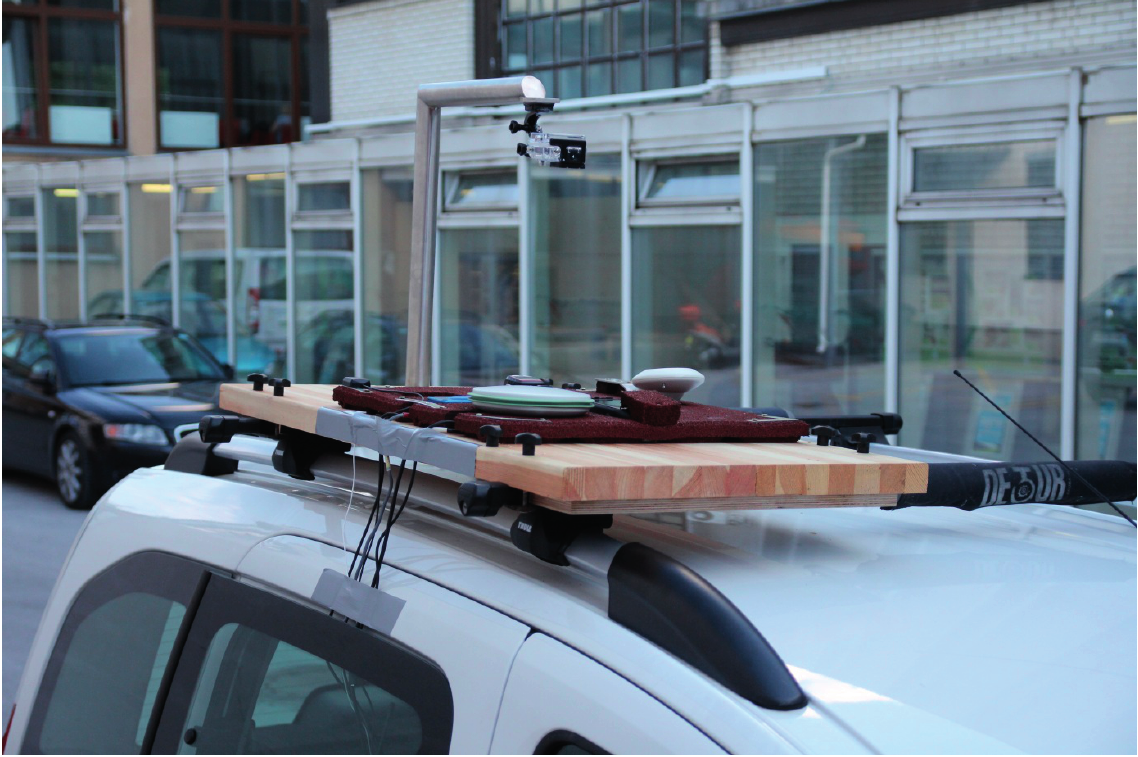
Figure 1. Custom-built platform for mounting GNSS devices and cameras on the roof rack of the